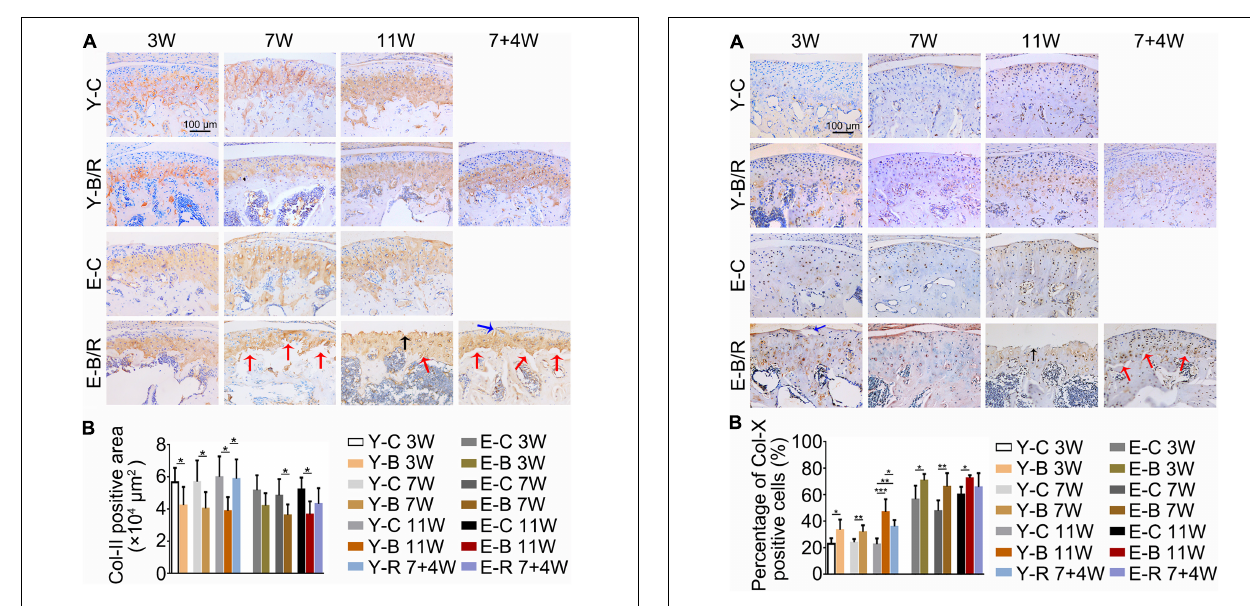
FIGURE 9 | (A) Representative immunohistochemical staining of type X collagen (Col-X). The black arrow indicates the serrated injury at the surface of the cartilage. The blue arrow indicates the fissure at the surface of cartilage. The red arrows indicate the fissures between cartilage and subchondral bone. Bars = 100 µ m. (B) Comparisons of the percentages of Col-X positive cells in the cartilage between the groups. Data are presented as mean ± SD. Unpaired t -test was used for comparisons between the age-matched control and BAC groups. One-way ANOVA was used for comparisons among the age-matched control, BAC, and BAC removal groups. n = 6. * P < 0.05; ** P < 0.01 and *** P < 0.001 for the differences between all BAC and removal groups and the age-matched control groups. For grouping and time points, please refer to Figure 1A